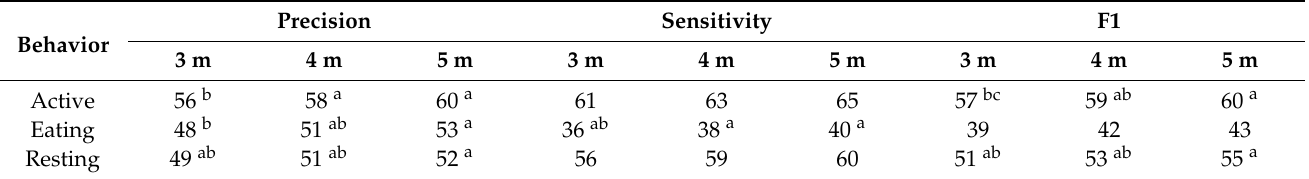
Table 5. The least square means of the classification performance of collar-fitted triaxial accelerometer sensor for the active, eating, and resting behaviors of cattle at different window sizes.